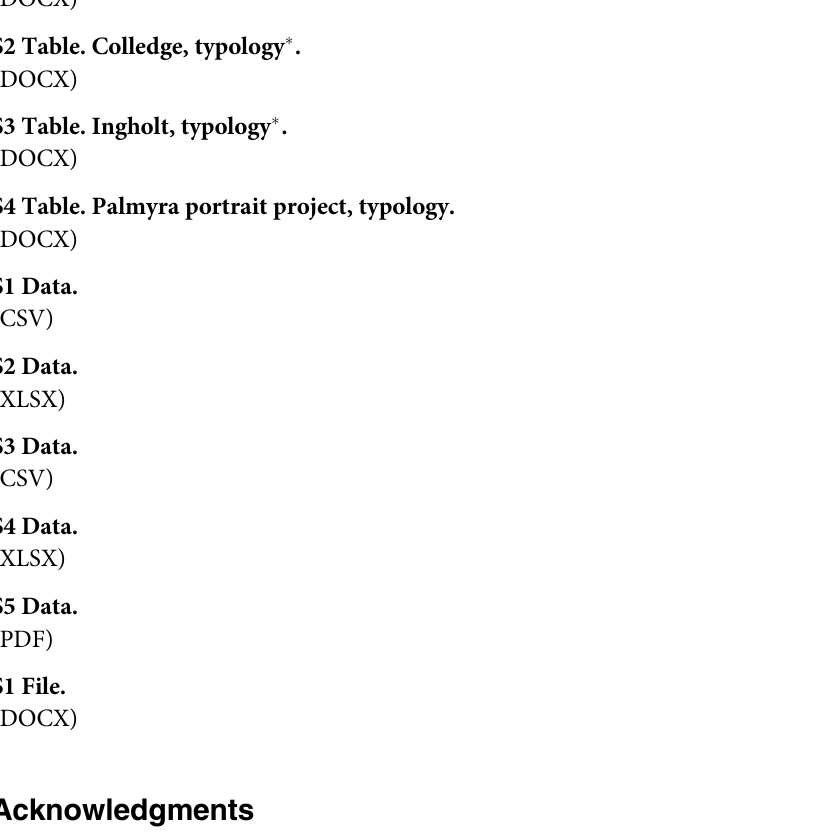
S4 Table. Palmyra portrait project,